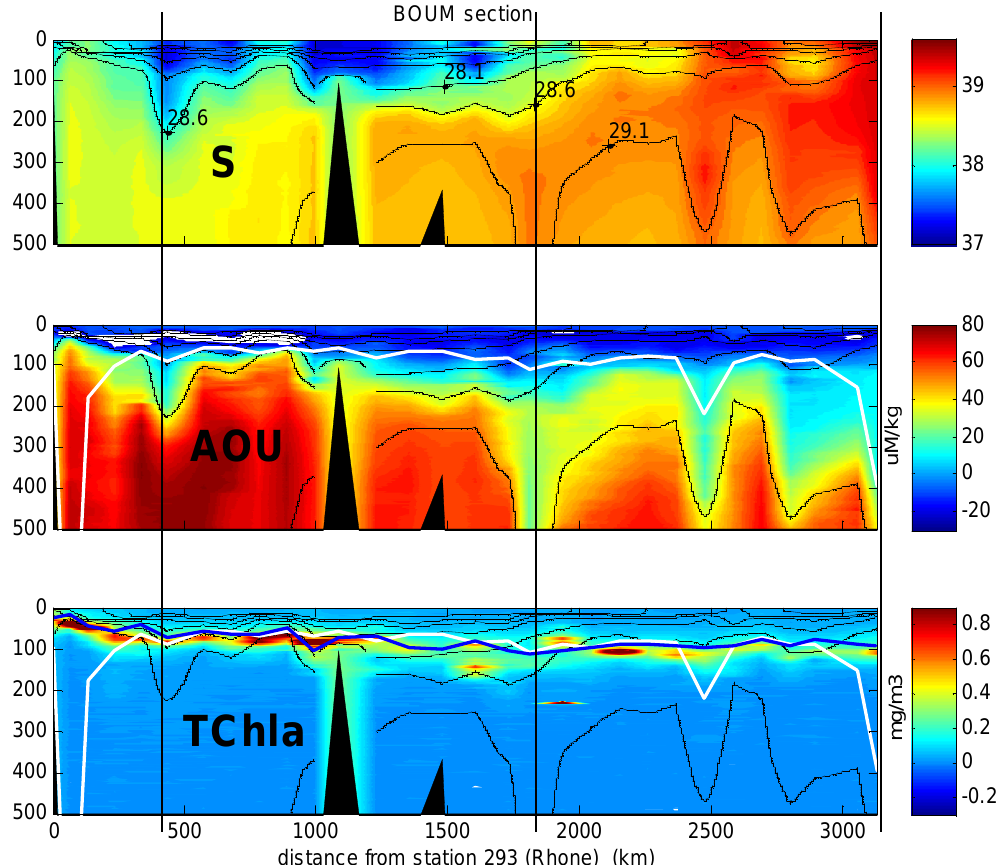
Fig. 6. Salinity, AOU (µmolkg − 1 ) and “Chlorophyll” section (in situ fluorescence units) along the BOUM transect (0–500dbars). W-MLD and the top nitracline (D NO ) are superimposed in white and blue lines on Fig. 6c, respectively. Isopycnals each 0.5kgm − 3 under 29.1 are 3 drawn in thin black